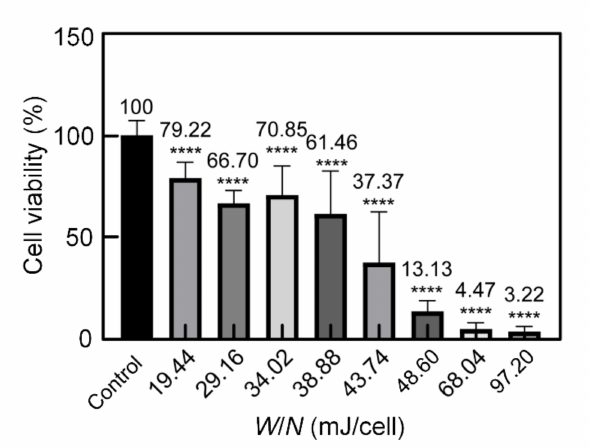
Figure 5. Variation of the cell viability with the value of ( W / N ). **** p <